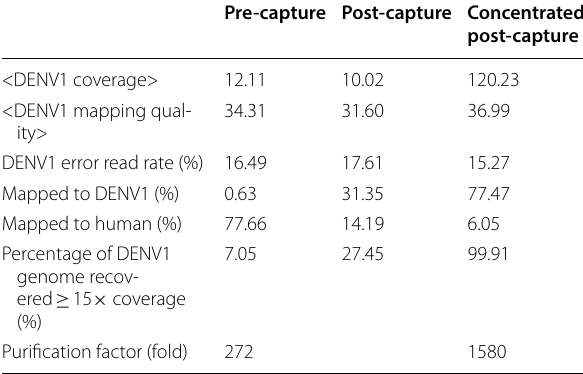
Table 2 Summary of bioinformatic analysis for pre